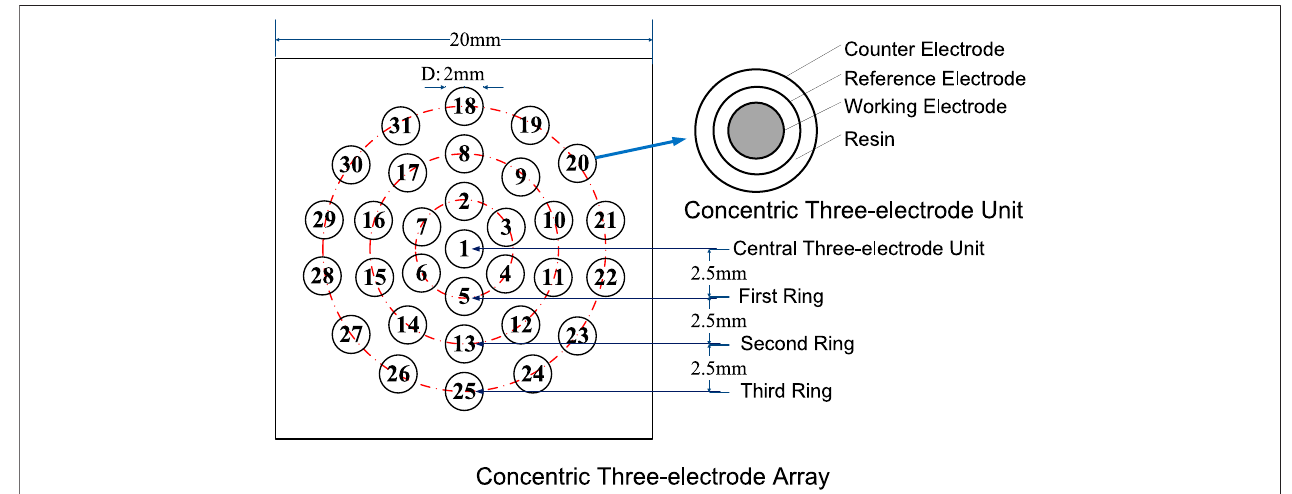
FIGURE 1 | Schematic representation of the